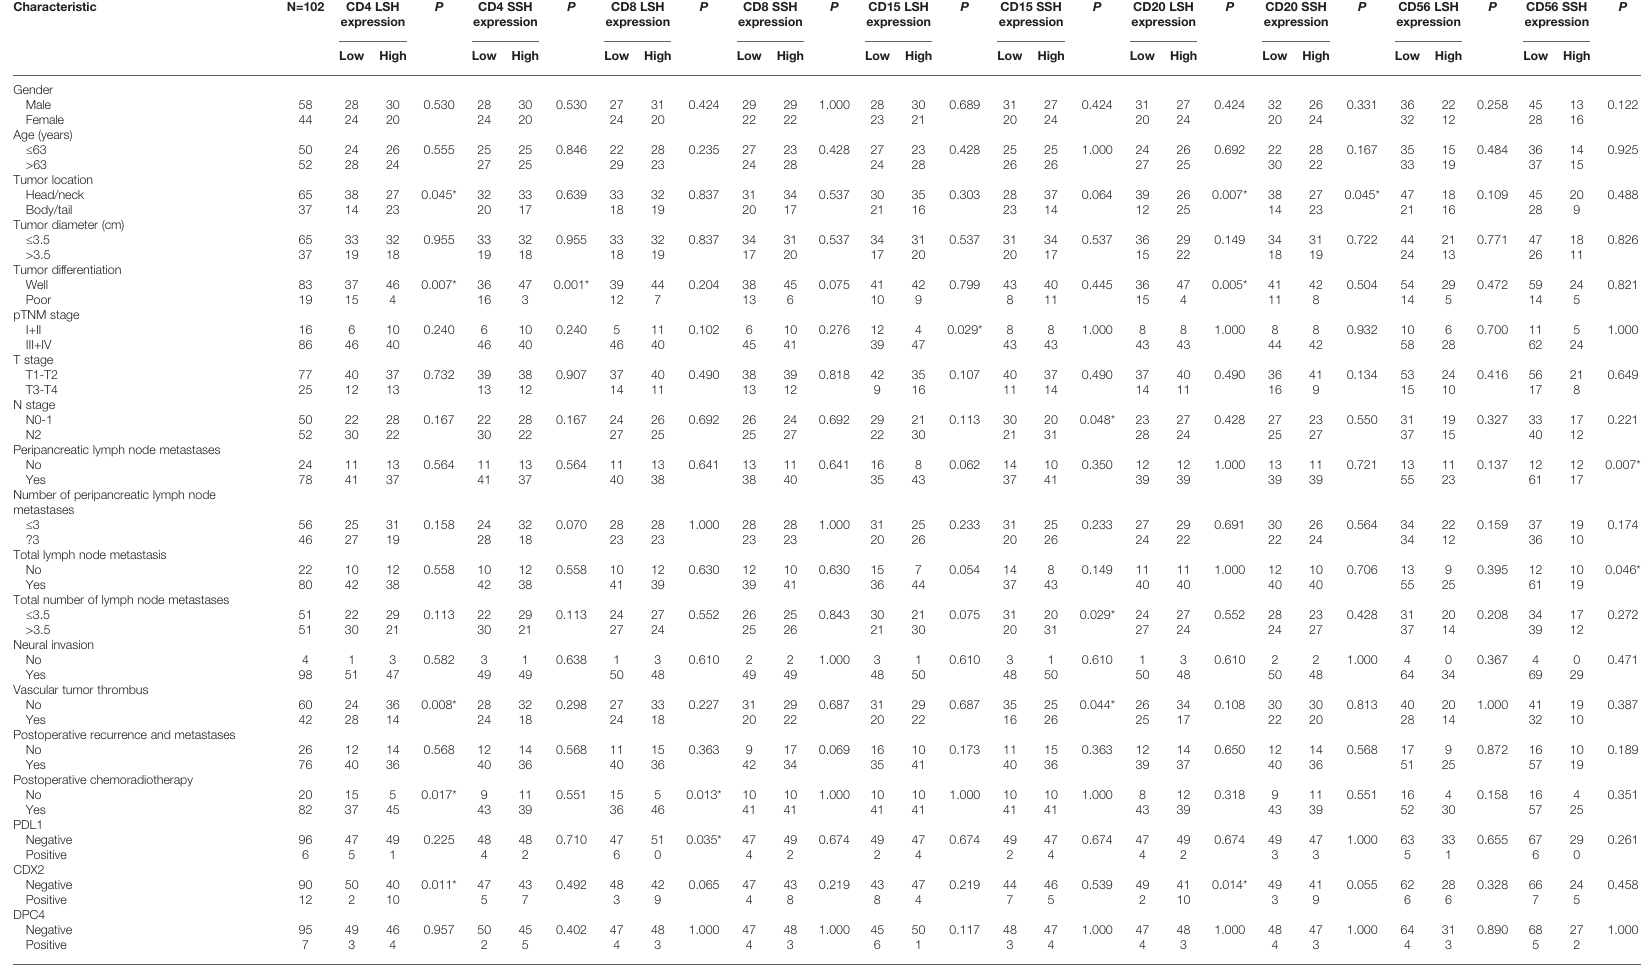
TABLE 2 | Relationship between CD4, CD8, CD15, CD20, CD56, PDL1, CDX2, and DPC4 expression and clinicopathologic features of PDAC.